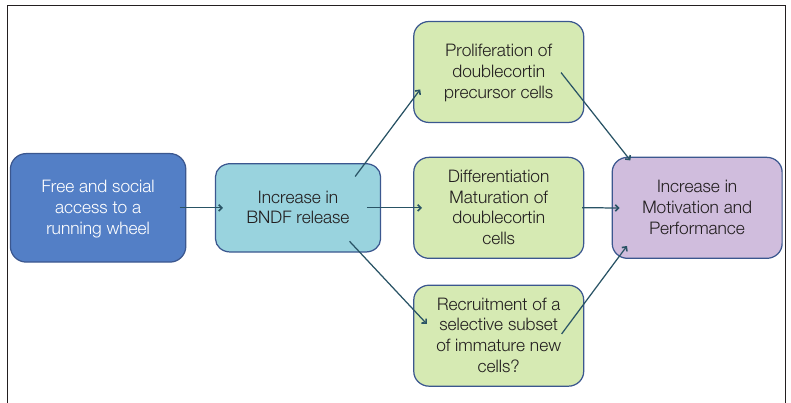
FigURe 3 | Working hypothesis. Free and social access to the running wheel would induce an increase in BDNF release that could act on (1) the proliferation of doublecortin-immunoreactive precursor cells, (2) on the dendritic arborization of doublecortin-immunoreactive immature neurons, stimulating their maturation and their differentiation, (3) on the selective recruitment of immature cells. These actions would thus lead to increased motivation and better cognitive